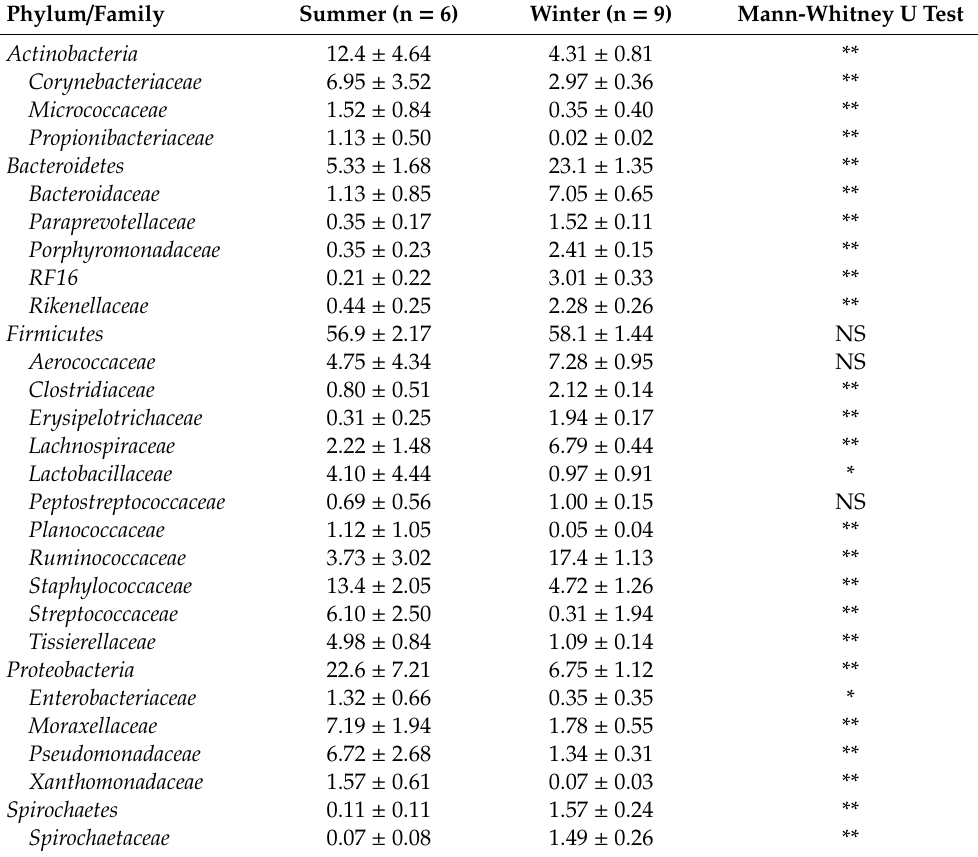
Table 5. Relative abundance (%) of air-borne dust microbiota of the dairy farm cowshed examined at two